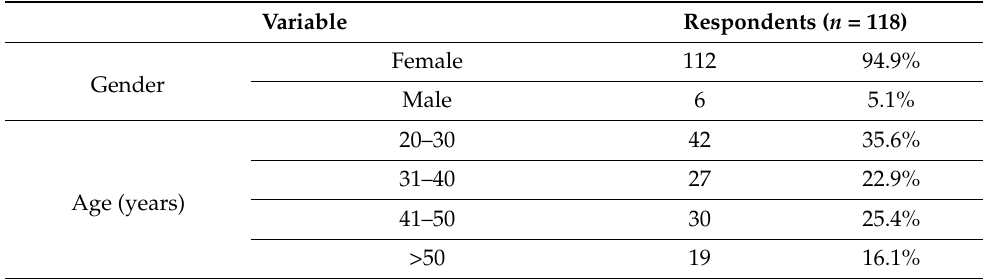
Table 1. Characteristics of the study